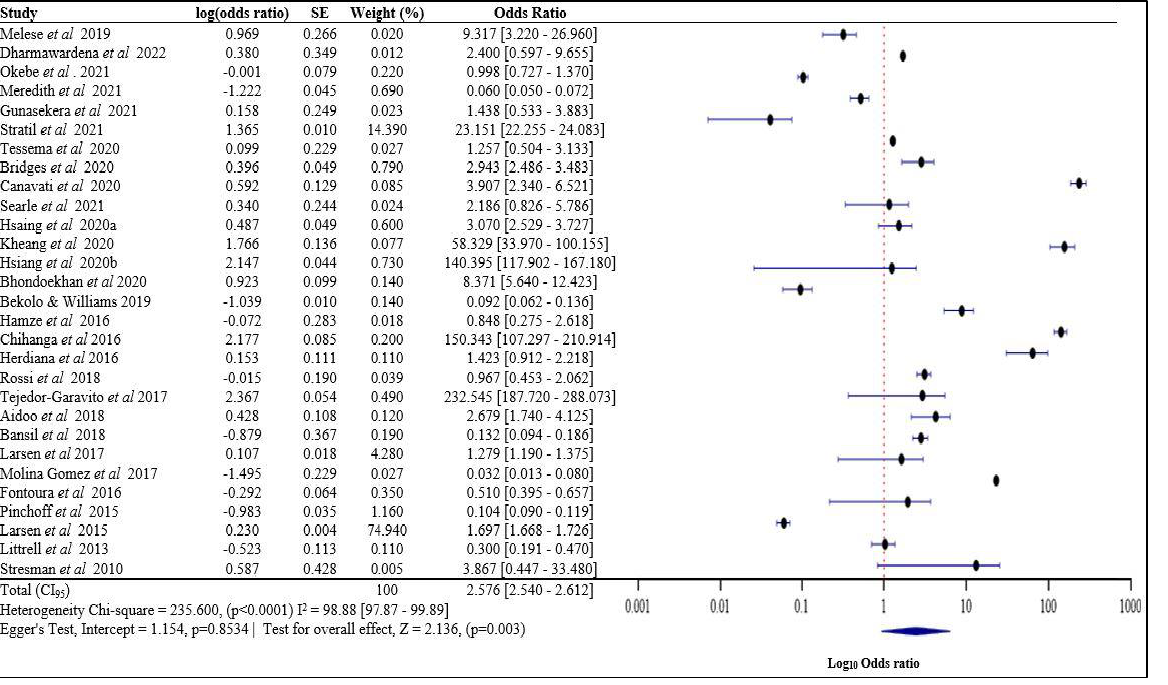
Figure 2. Risk of malaria infection amongst persons living with index cases [14, 15, 17-19, 23-25, 29-32, 34-37, 41, 46, 47, 50-52, 54, 55, 57, 62-64, 66].